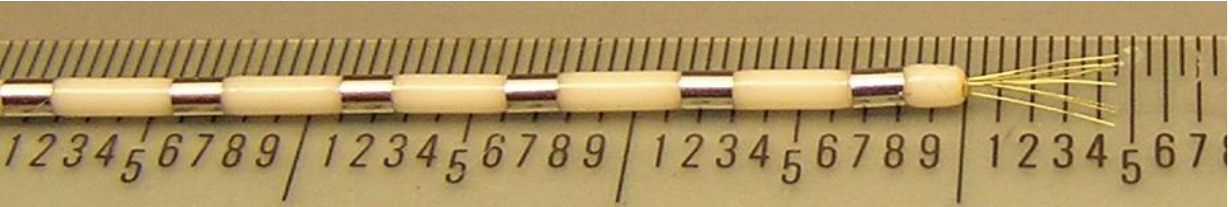
Figure A2. Image of clinical macroelectrode and microwire electrodes to scale. Numbers on the ruler indicate mm of